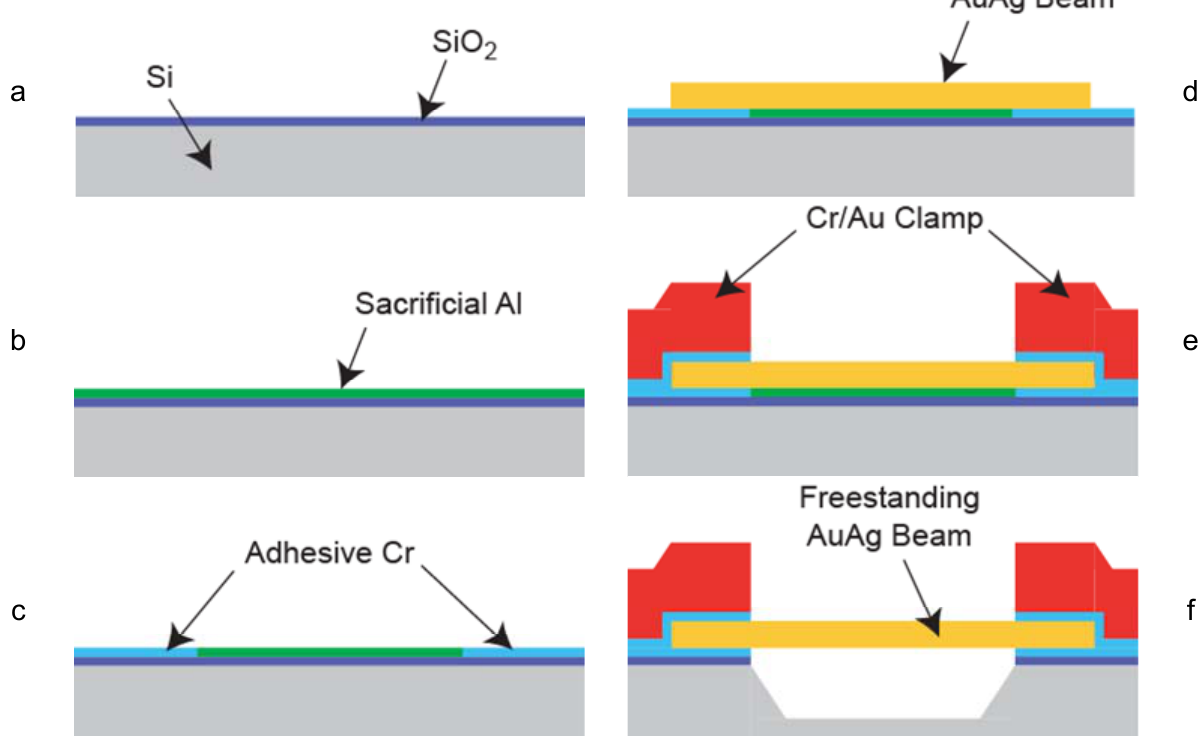
Figure 4. Schematic of freestanding Au-Ag beam fabrication: (a) ~80 nm-thick thermal SiO is deposited onto a p-type 50 mm Si (100) wafer; (b) ~60 nm-thick Al is sputter- 2 deposited to serve as a sacrificial layer; (c) planar foundation layer is produced by etching and photolithographic-patterning Cr pedestals for adhesion; (d) ~800 nm-thick Au Ag 0.3 0.7 (atomic fraction) beam is sputtered-deposited through a photoresist micro-stencil layer; (e) beam is clamped onto the substrate by sputter-depositing Cr (~50 nm-thick) and Au (~500 nm-thick), and subsequent electroplating of ~3 µm-thick Au; and (f) beam is released by consecutively etching Al, SiO , and Si, and critical-point drying. 2